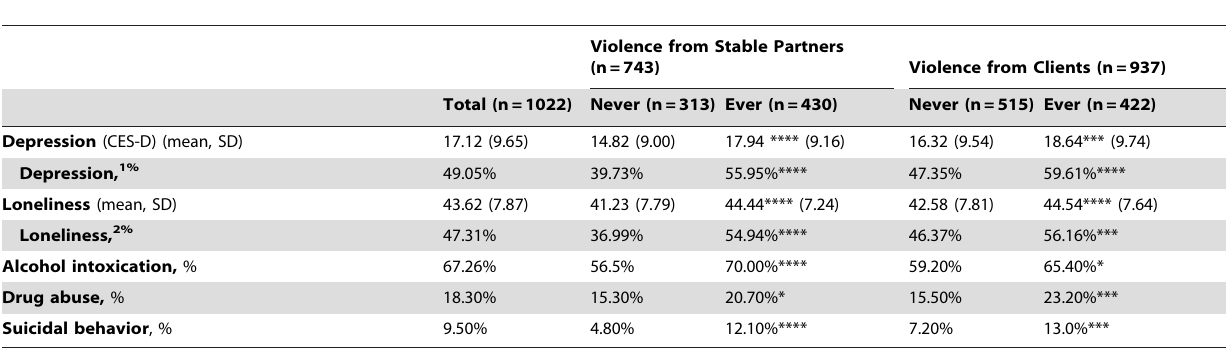
Table 3. Association between Partner Violence and psychosocial